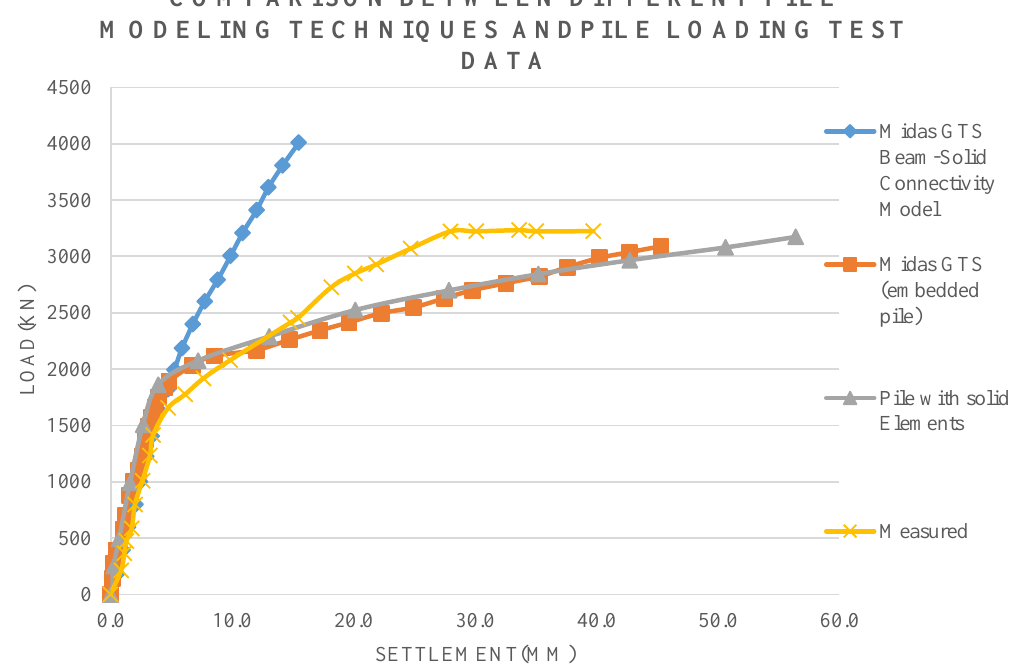
Fig. 13. A comparison between the pile's modeling techniques and test